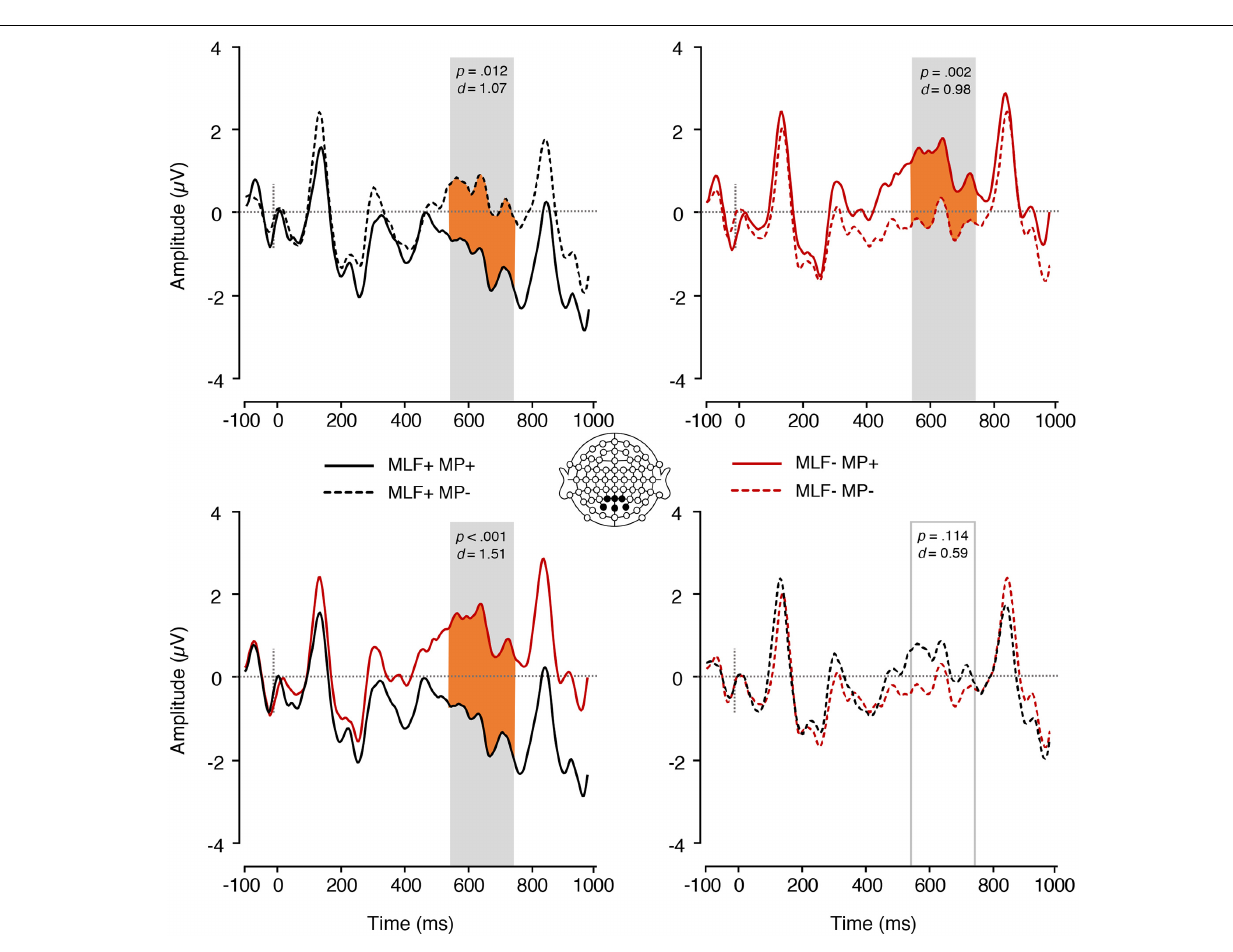
FIGURE 6 | ERPs elicited by adjectives preceded by nouns, depicting the interaction between MLF and MP. The plain grey box indicates the time window of the analysis in which mean ERP amplitudes significantly differed between conditions (550–750 ms post-stimulus). MLF, Matrix Language Framework; MP, Minimal Programme; +, stimuli compliant with prediction; –, stimulus violating